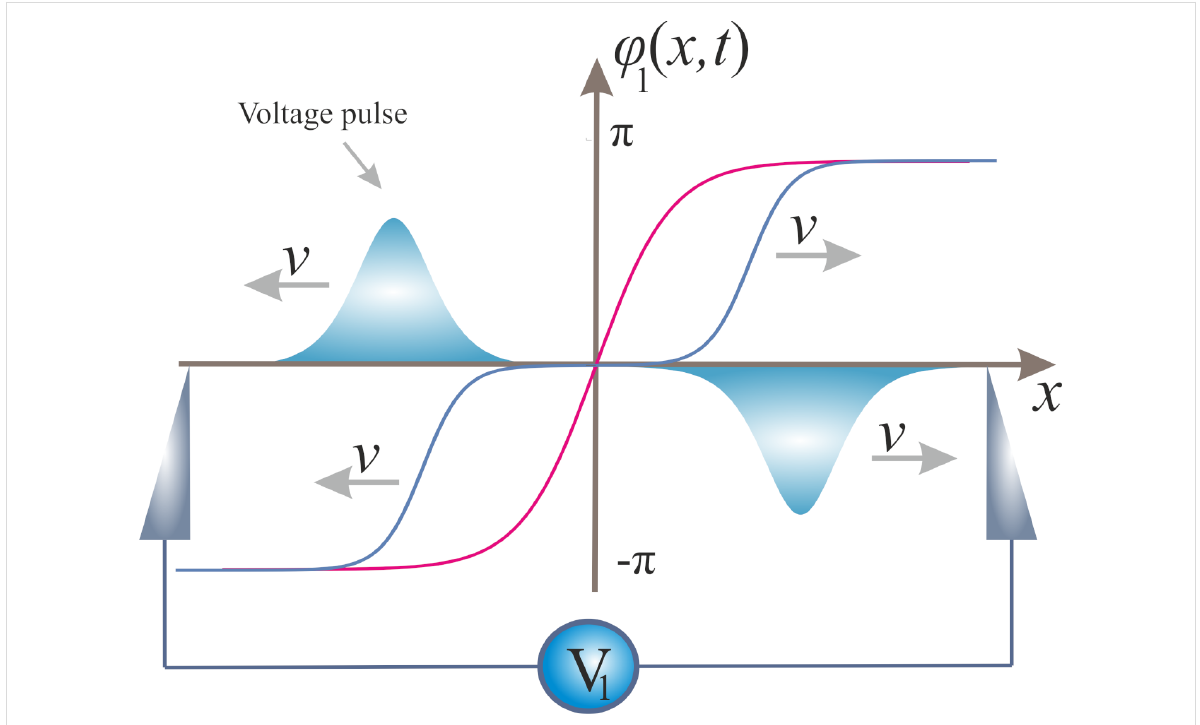
Figure 2: Time-dependent phase configurations describing a QPS event at t = 0 (red) and t > 0 (blue) together with propagating voltage pulses gener- ated by this QPS event in a single superconducting